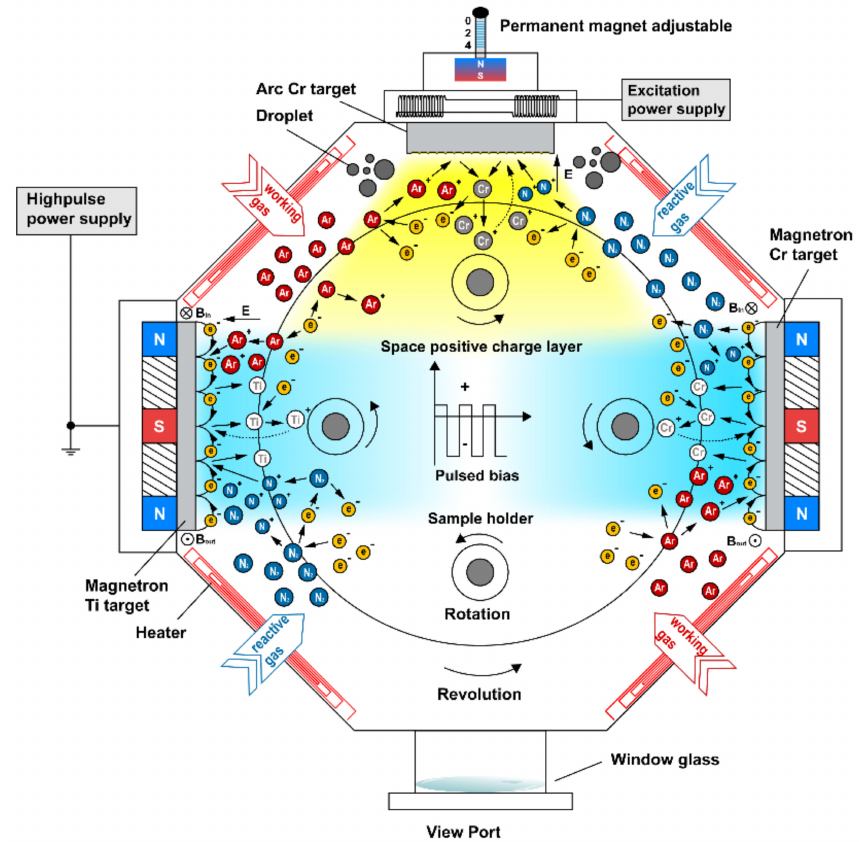
Figure 1. Scheme of stage to pulsed magnetron sputtering and arc ion plating